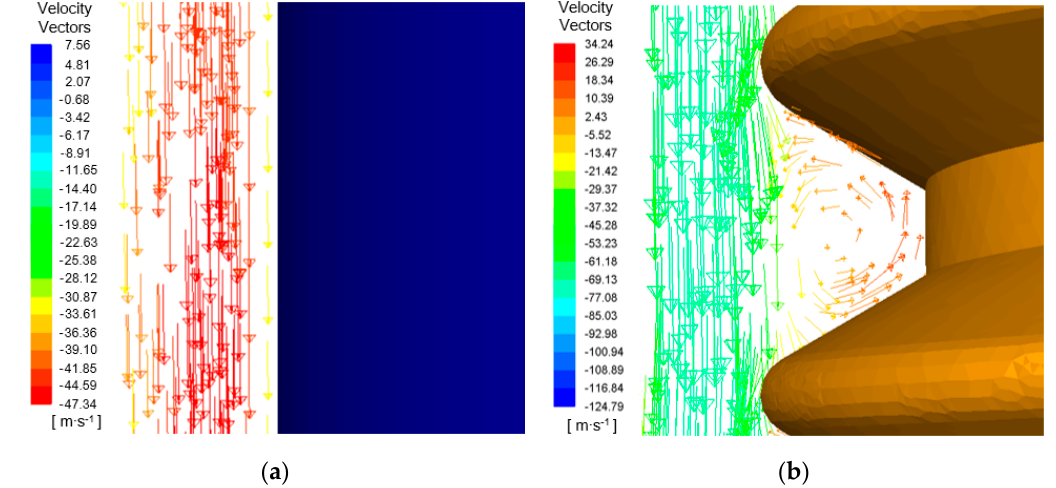
Figure 3. Velocity vectors in the axial direction in the machining gap using different tube tool electrodes: ( a ) cylindrical tube electrode; ( b ) helical tube electrode.